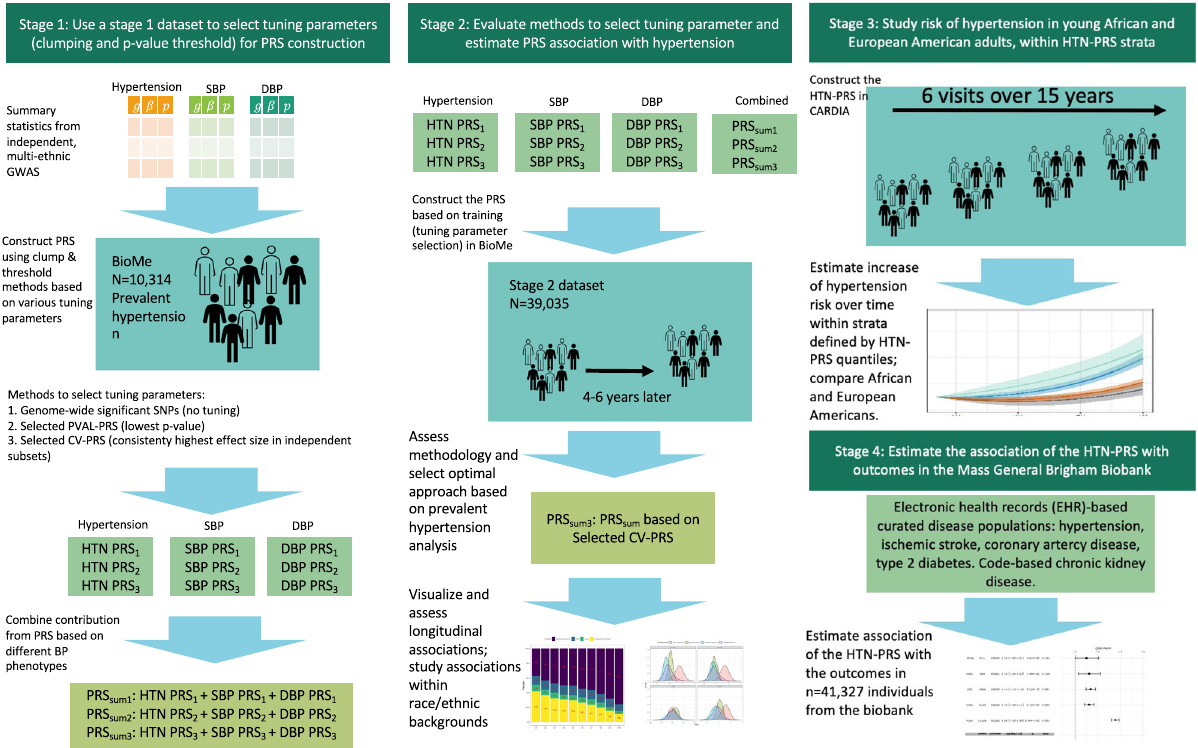
Fig. 1 Study organization. In stage 1, we used the stage 1 dataset to select tuning parameters for PRS construction based on GWAS of BP phenotypes. We compared a few methods for tuning parameter selection and constructed PRSsum combining a few phenotype-speci fi c PRS. In stage 2 we evaluate the methods for tuning parameter selection in the stage 2 dataset, and selected one PRS, namely HTN-PRS, to move forward for two-visit longitudinal analysis. In stage 3, we used a longitudinal dataset from CARDIA to study hypertension development in young adults, and compared Black and White individuals. In stage 4, we tested the association of the HTN-PRS with disease outcomes in MGB biobank (stage 4